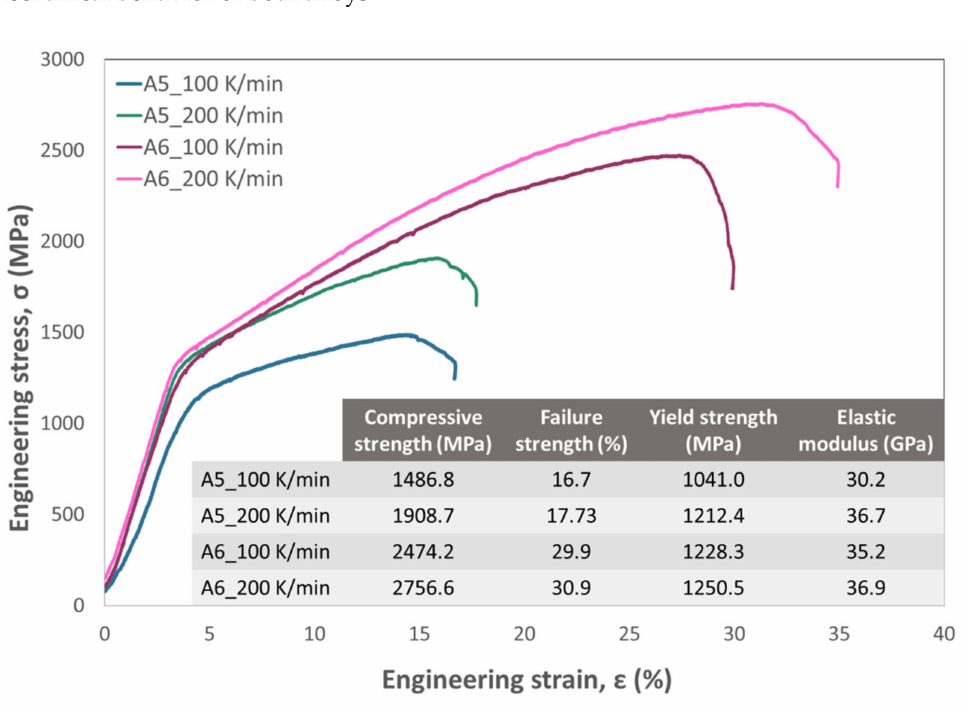
Figure 6. Engineering stress–strain curves of SPS A5 and A6 samples sintered at 100 and 200